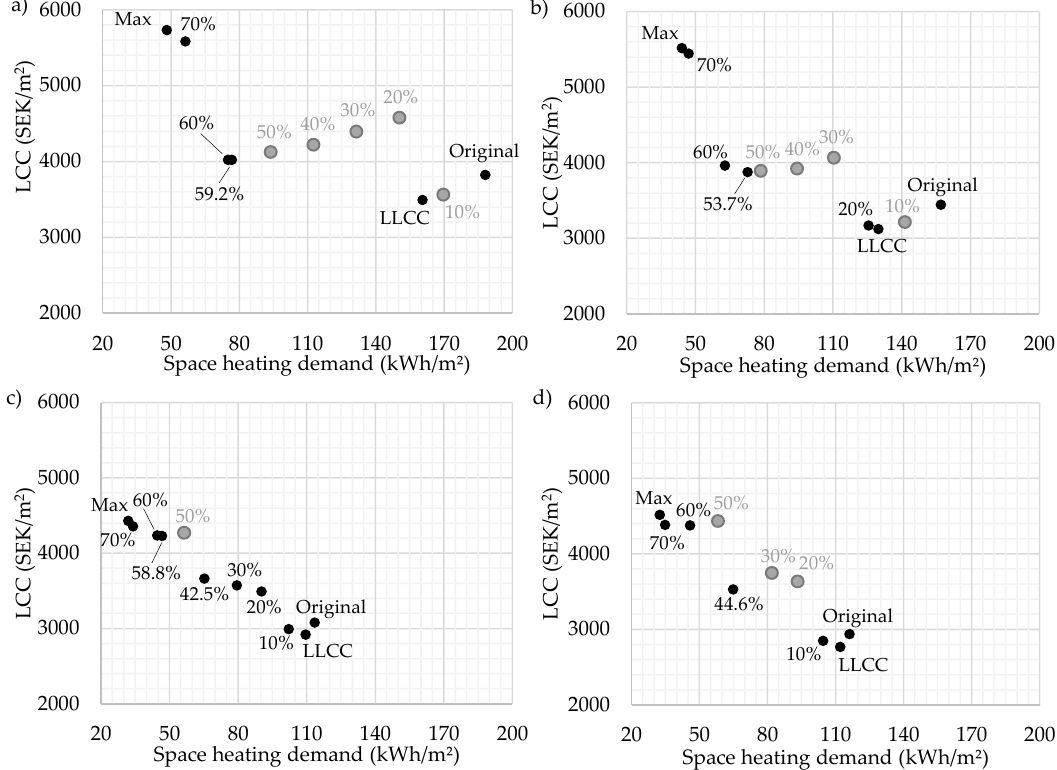
Figure 5. Increase in LCC for different energy saving targets for the buildings from the 1940s (a), the 1950s (b), the 1960s (c), and the 1970s (d). Gray indicates that the combination of energy efficiency measures is not optimal. LLCC—lowest LCC.